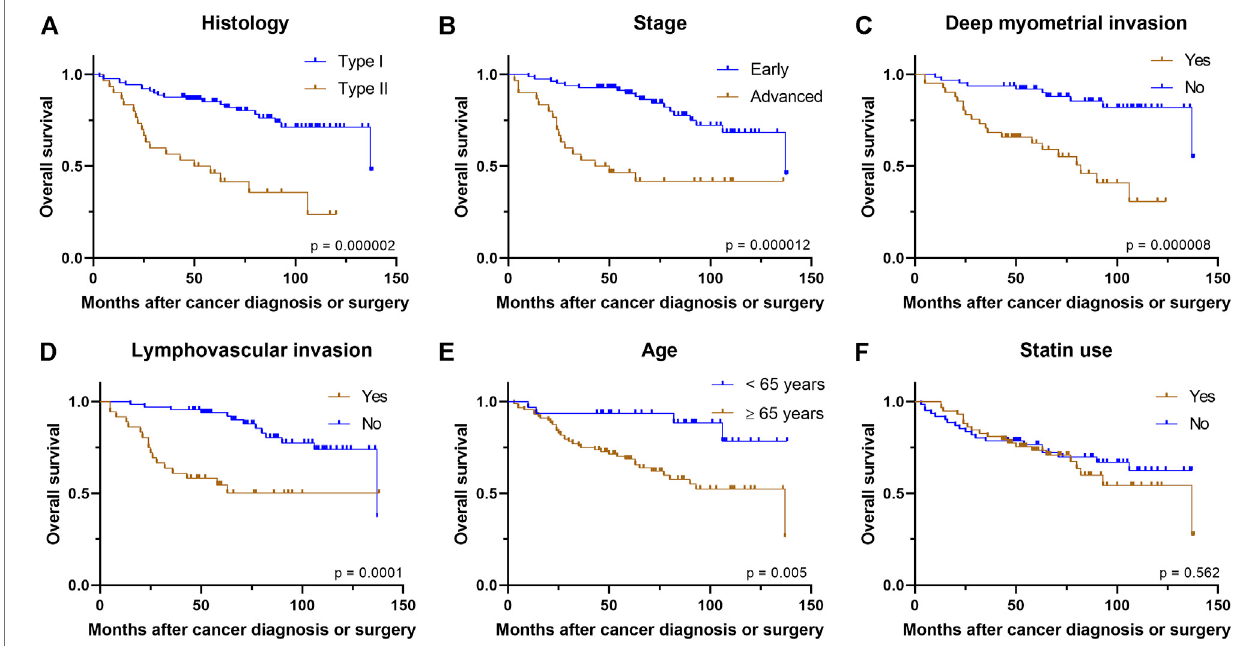
FIGURE2| Kaplan – Meiercurvesdemonstrateassociationsbetween (A) histology (B) stage (C) deepmyometrialinvasion (D) presenceoflymphovascularinvasion (E) age, or (F) statin use and overall survival.